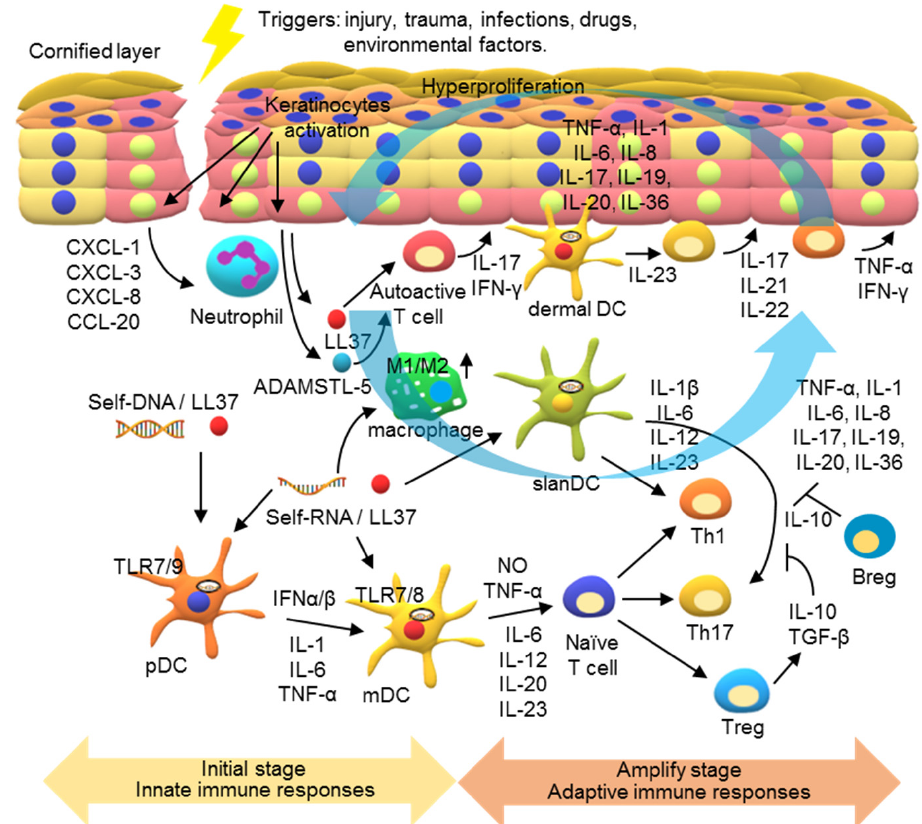
Figure 5. A model for the pathogenesis of psoriasis. In the initial stage of psoriasis, environmental stress, such as skin damage and infection, causes the release of damage-associated molecular patterns (DAMPs), such as self-RNA and self-DNA. Antimicrobial peptides (AMPs), such as LL-37 released from keratinocytes, can bind to these self-nucleic acids, inducing innate immune responses in the psoriatic lesions. The LL-37/DNA complex activates TLR7 and TLR9 in plasmacytoid dendritic cells (pDCs) to release pro-inflammatory cytokines and type I IFNs, which activate the maturation of myeloid dendritic cells (mDCs). LL37/RNA complexes can also activate TLR8 in mDCs to produce IL-12 and IL-23. Moreover, the polarization of macrophages into the M1 subset can be activated to produce pro-inflammation cytokines at this stage. In the development phase of psoriasis, adaptive immune responses are activated and psoriatic inflammation is amplified. The cytokines in the psoriatic lesions activate Th1 and Th17 cells for production of various cytokines to contribute to the inflammatory milieu and act on keratinocytes. The keratinocytes are then activated to produce inflammatory cytokines, chemokines, and AMPs to recruit leukocyte infiltrates and activations, forming a self-amplifying feedback loop in the psoriatic inflammatory